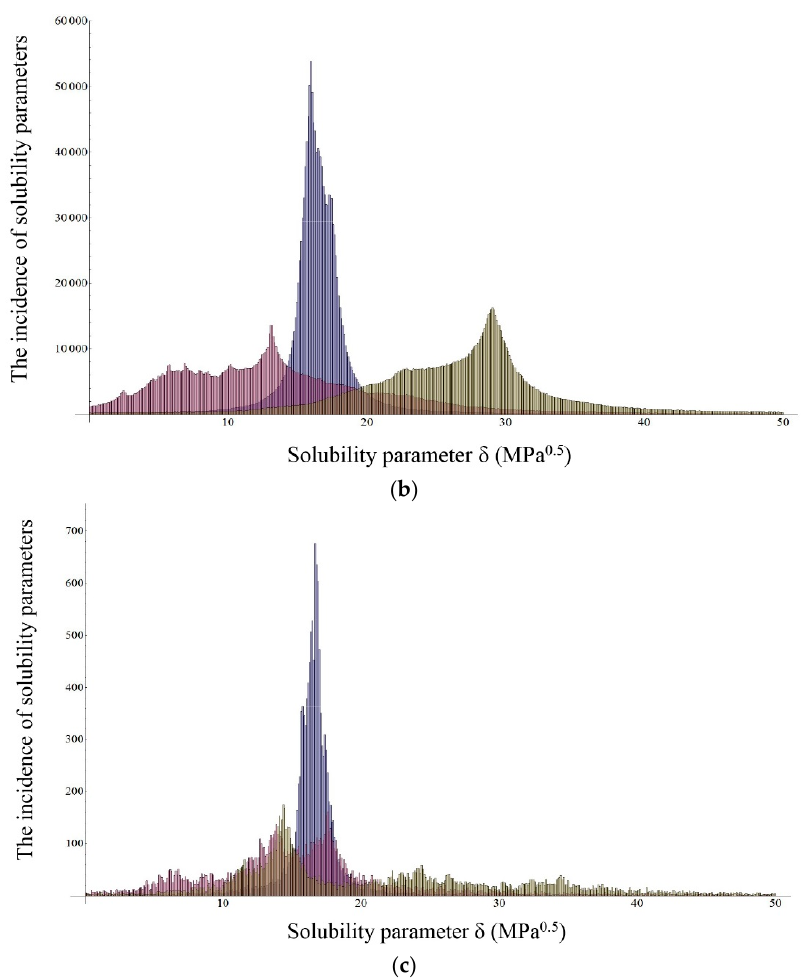
Figure 2. Histograms of most common values of partial solubility parameters obtained by Extended Hansen’s Approach for ( a ) ibuprofen; ( b ) sodium ibuprofenate; ( c ) ibuprofen lysinate; blue color represents values of δ d , red color represents values of δ p and green color represents values of δ h .